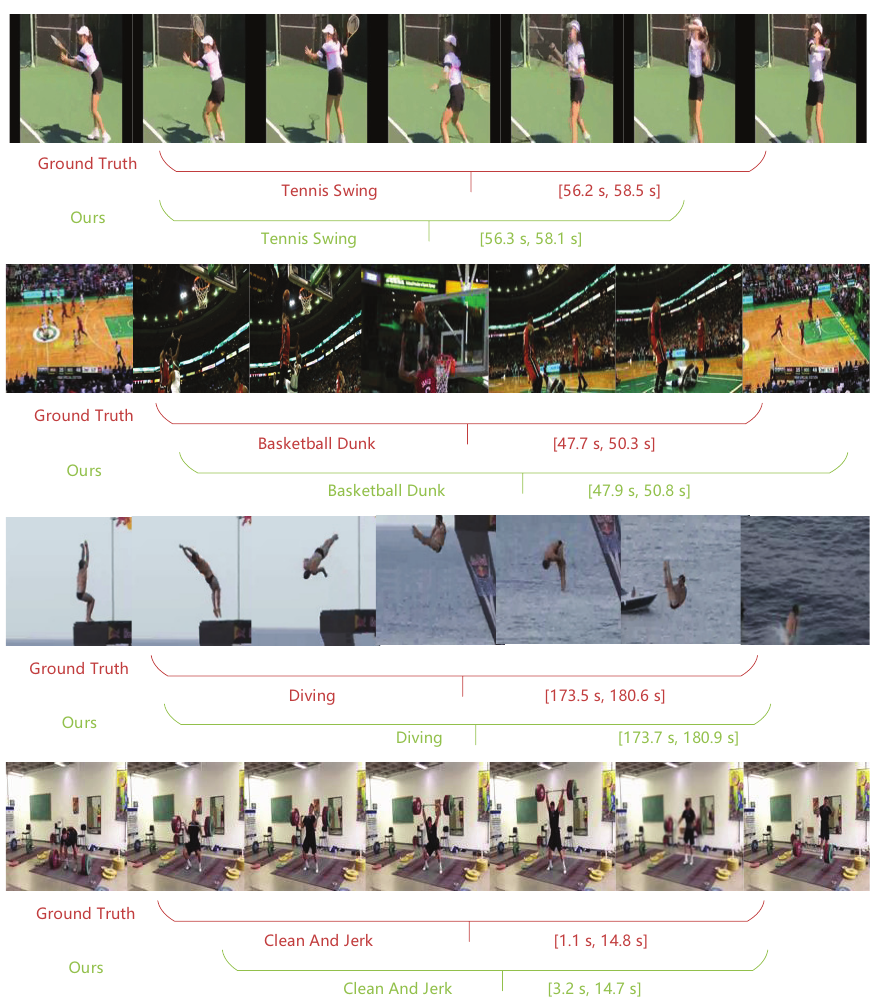
Figure 2. Qualitative Results. Visualize ground truth and corresponding predicted instances on